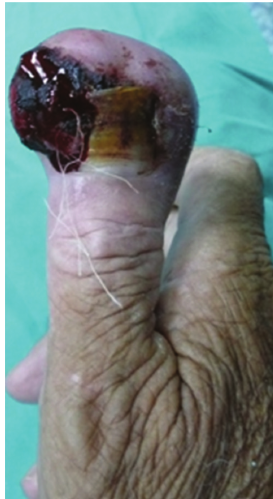
Figure 1: Swelling and hemorrhaging at distal part of the right thumb.